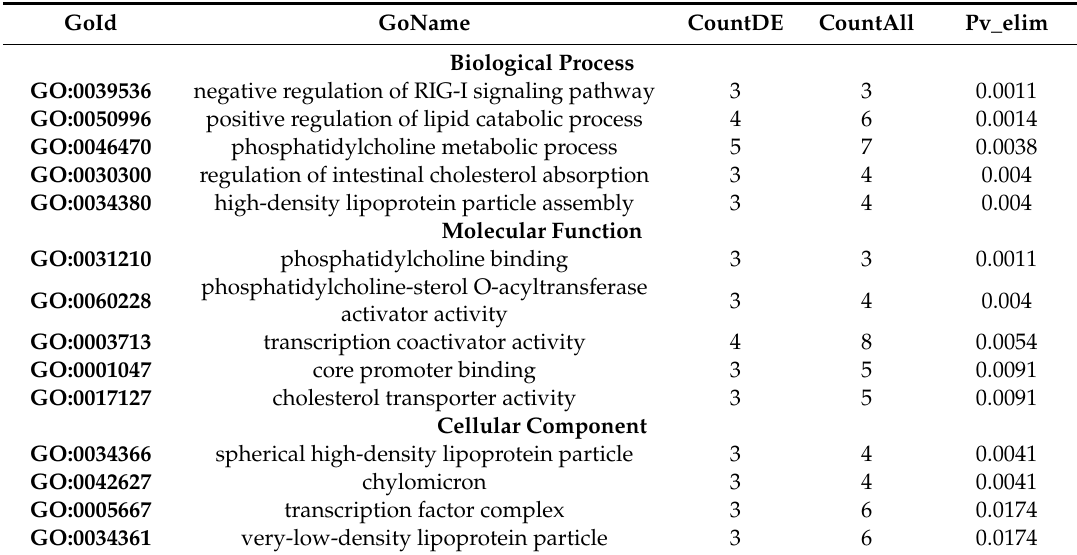
Table 3. GO terms enriched in BAT.